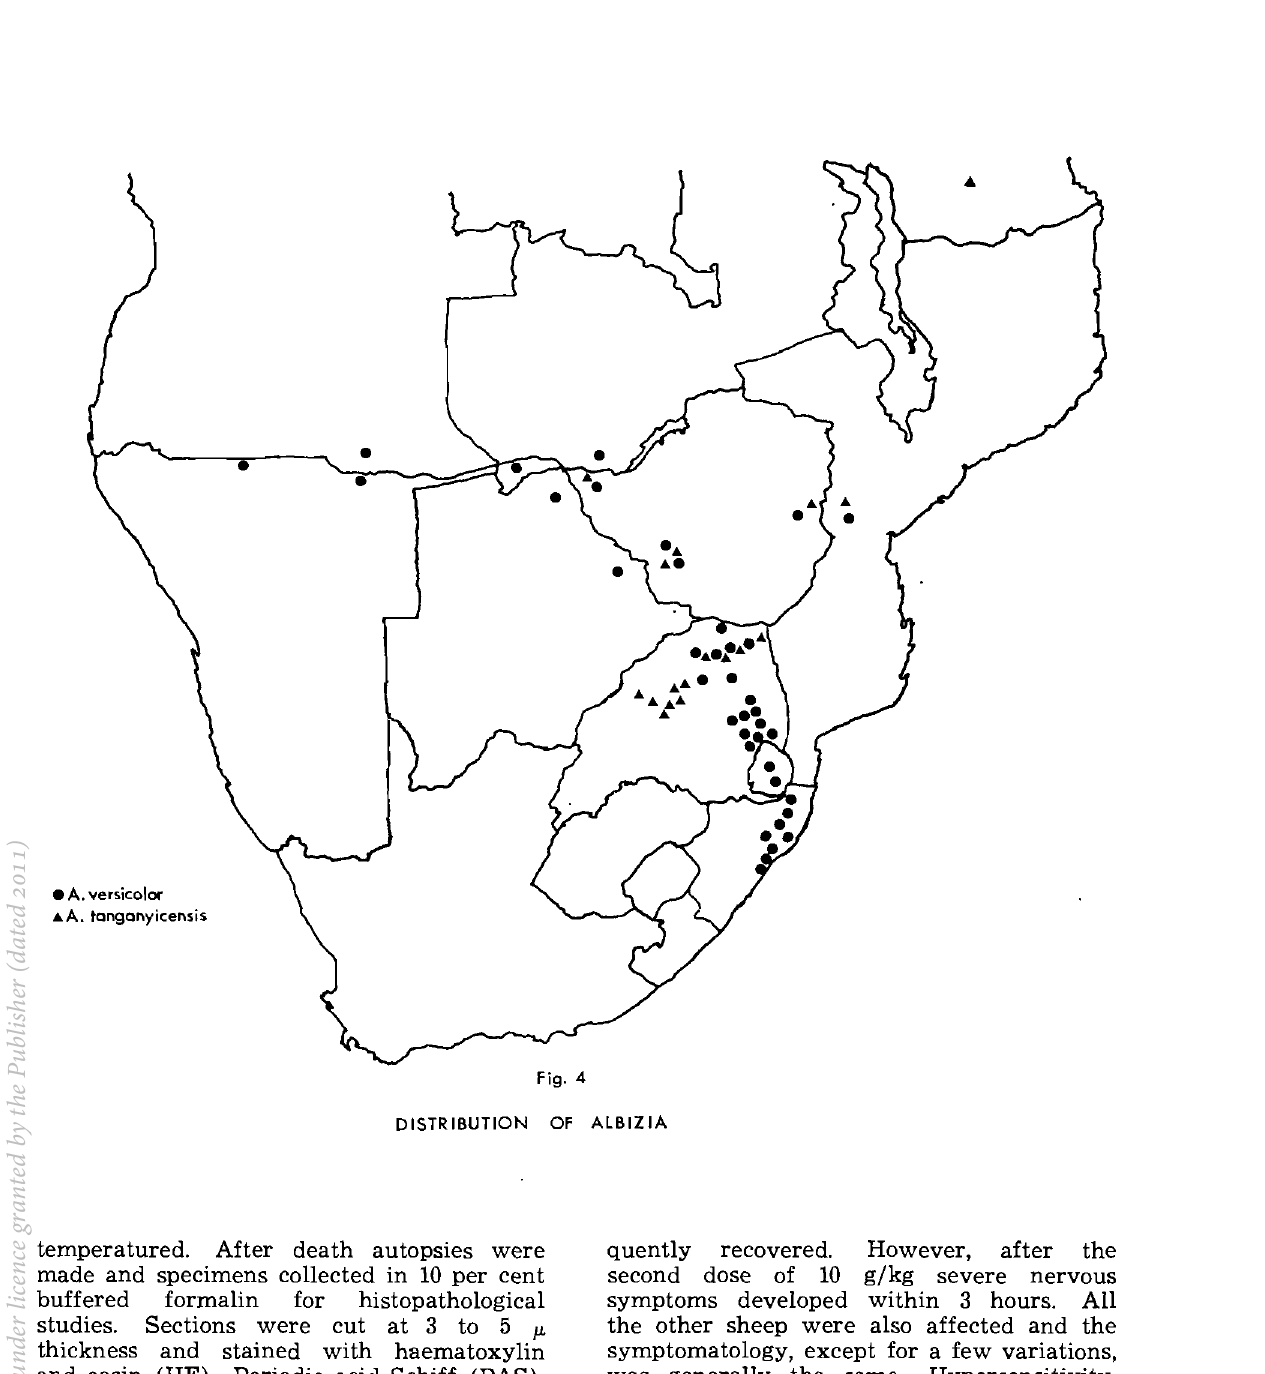
DISTRIBUTION OF